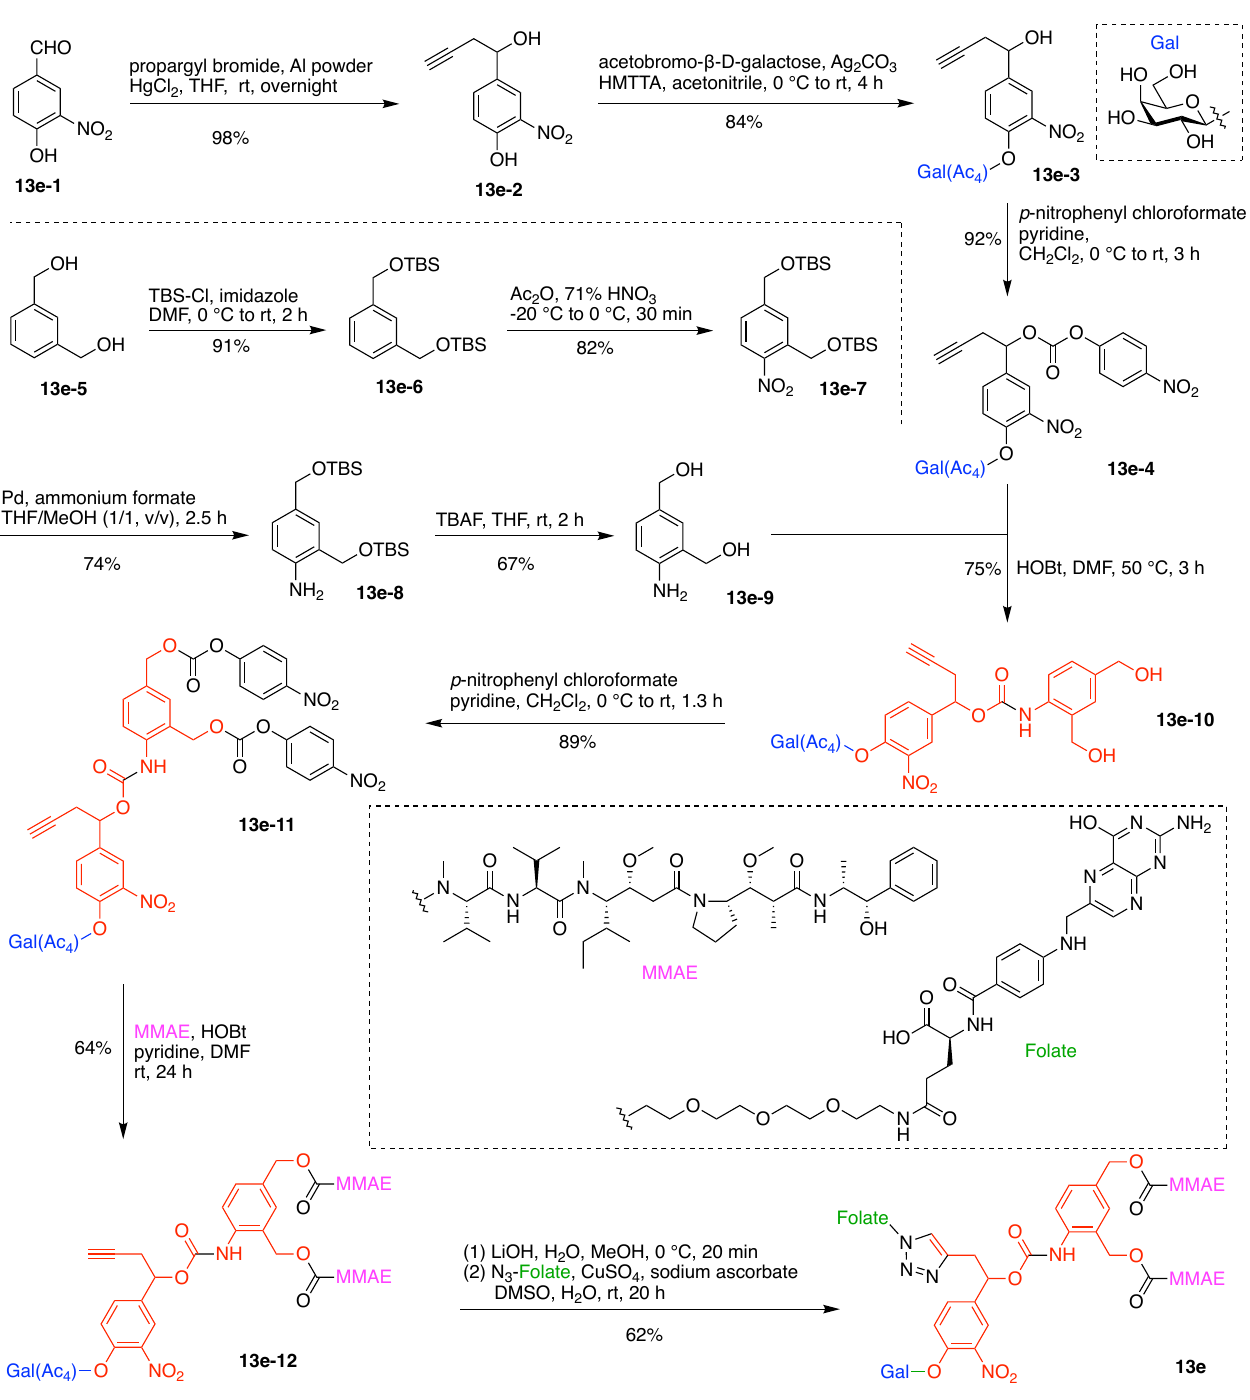
Figure 65. Synthesis of a tetra-substituted scaffold.